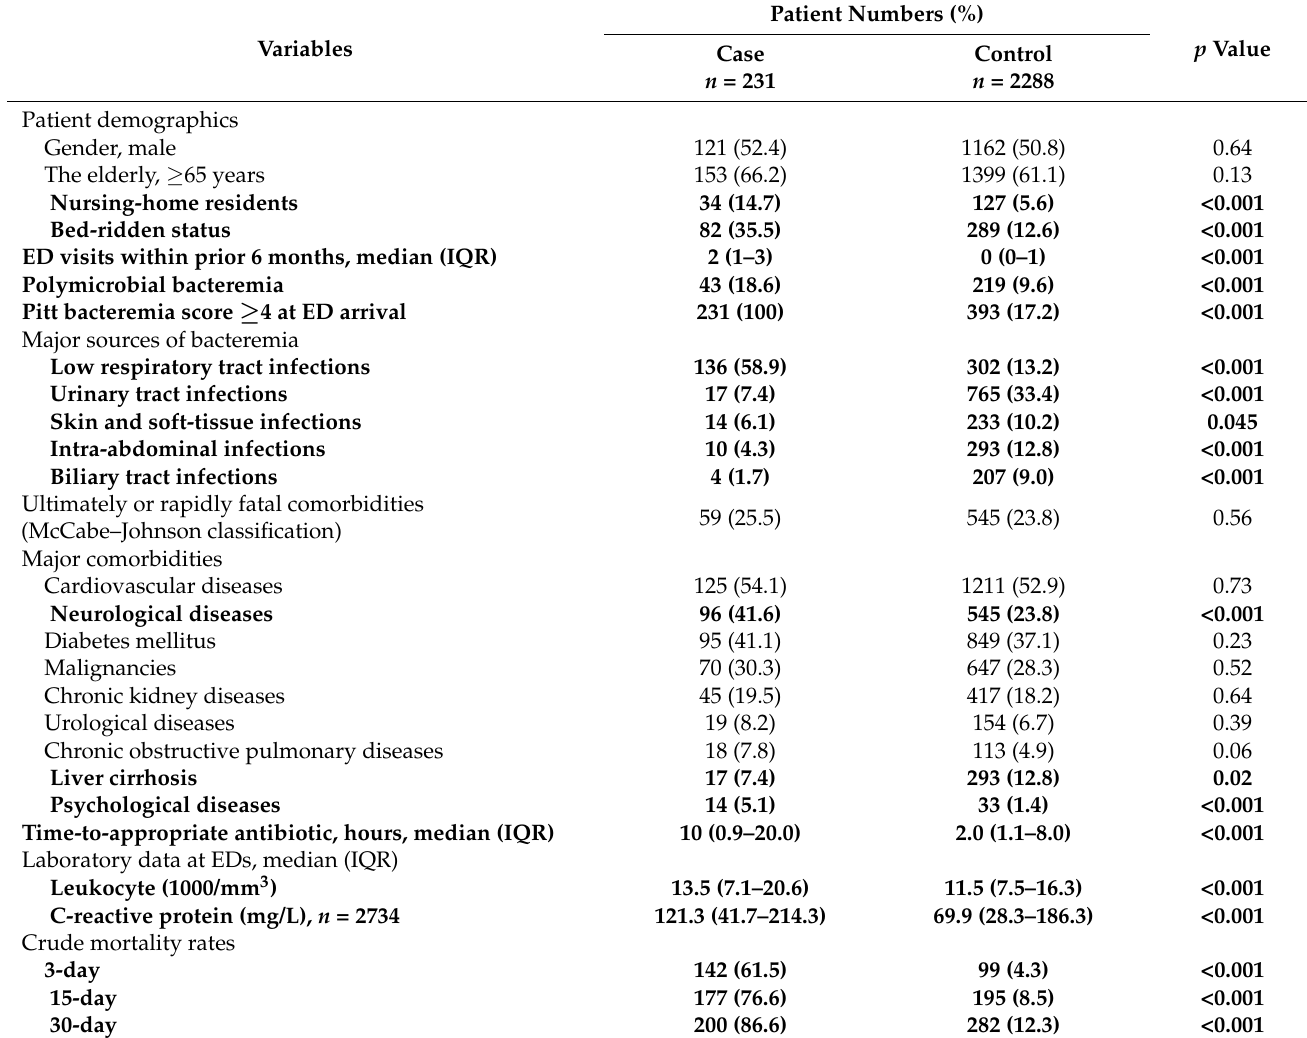
Table 1. Clinical manifestations and outcomes of community-onset bacteremia in case and control patients *.